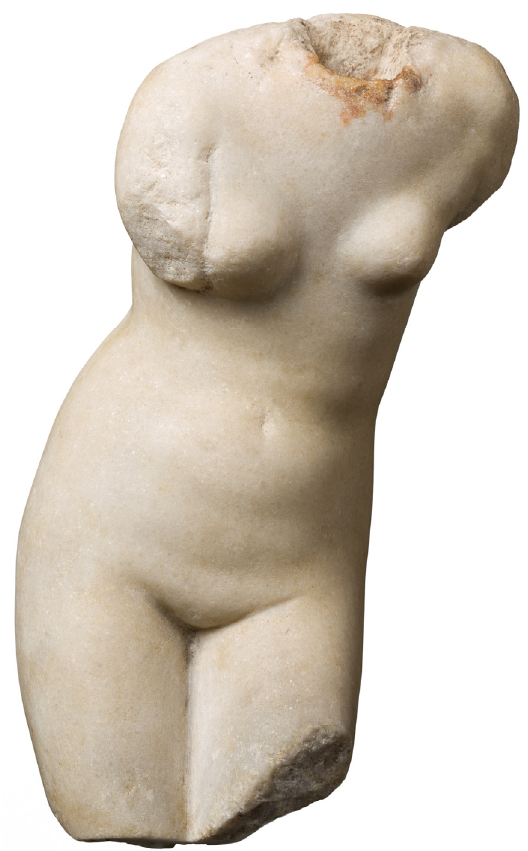
Figure 2. Micro-Asian island statuary production (Greek island/Rhodium), Torsetto femminile (female torsos) , mid-II century BCE Parian marble Lakkoi/sculpture, 280 × 135 mm, Museum no. MB95,